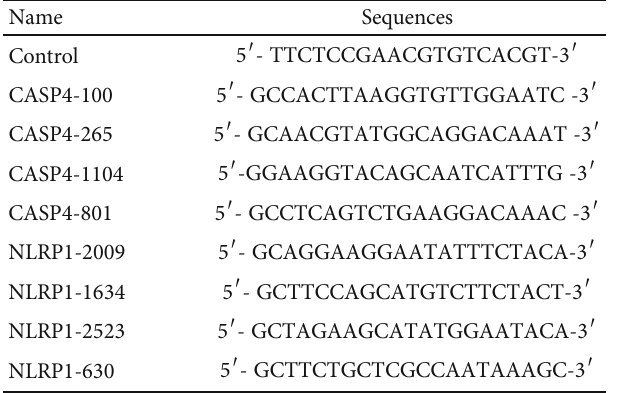
Table 1: Sequences used for shRNA